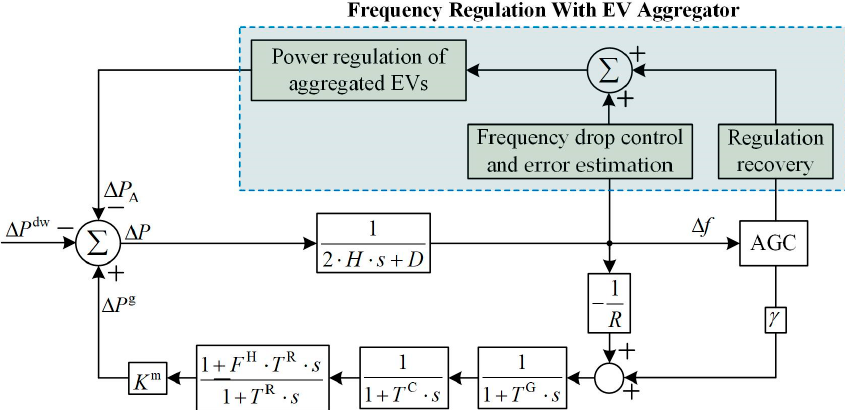
Figure 6. Equivalent frequency regulation model of the power system with the EV aggregator. Table 1. Parameters of the equivalent-system frequency regulation model.